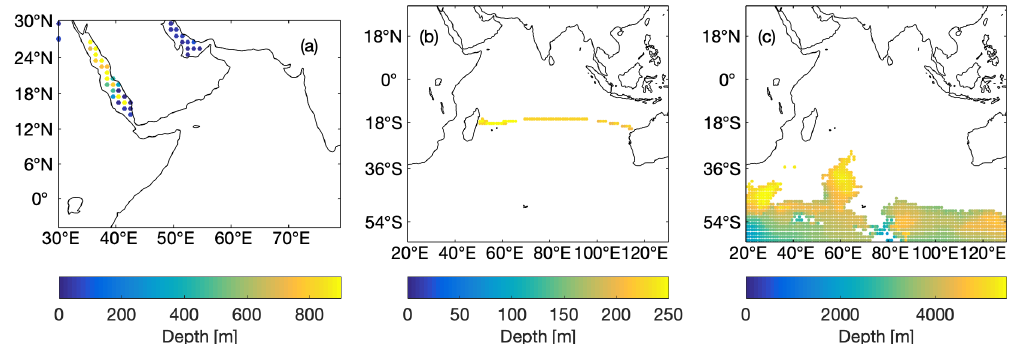
Figure 2. Origins of the water mass formation regions from observations (WOA13) for (a) Red Sea and Persian Gulf Water, (b) Indian Central Water, and (c) Indian Ocean Deep Water. The colours indicate the deepest depth at each grid point wherein the respective water mass properties are found.